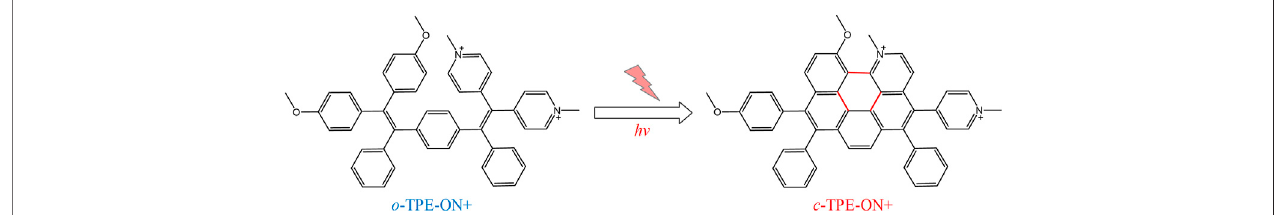
FIGURE 2 | The photocyclodehydrogenation process of o -TPE-ON+ (Gu et al., 2016)